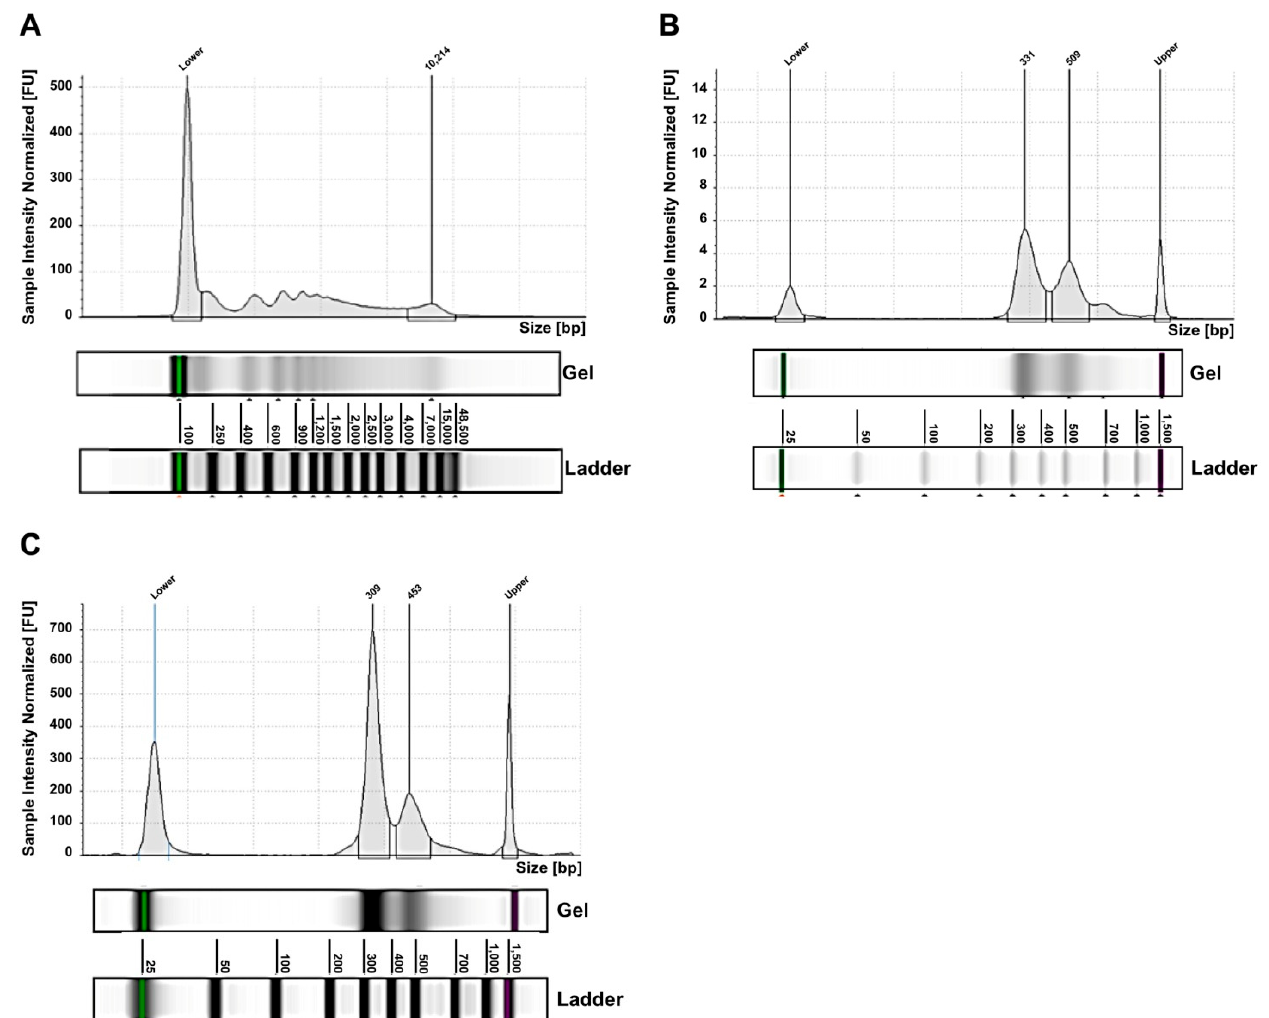
Figure 1. Exo-DNA size profiling (Tape Station 4150). ( A ) Representative electropherogram of exo-DNA. ( B ) Exo-DNA library. ( C ) Target enrichment capture of exo-DNA (FU = fluorescence unit; bp = base pair).